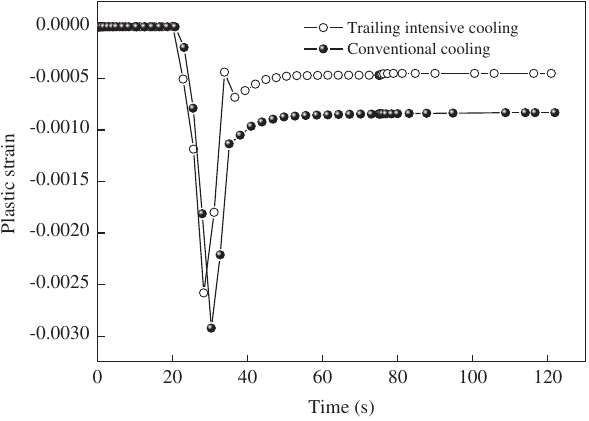
Figure 9: Plastic strain evolution of the center point of weld under different